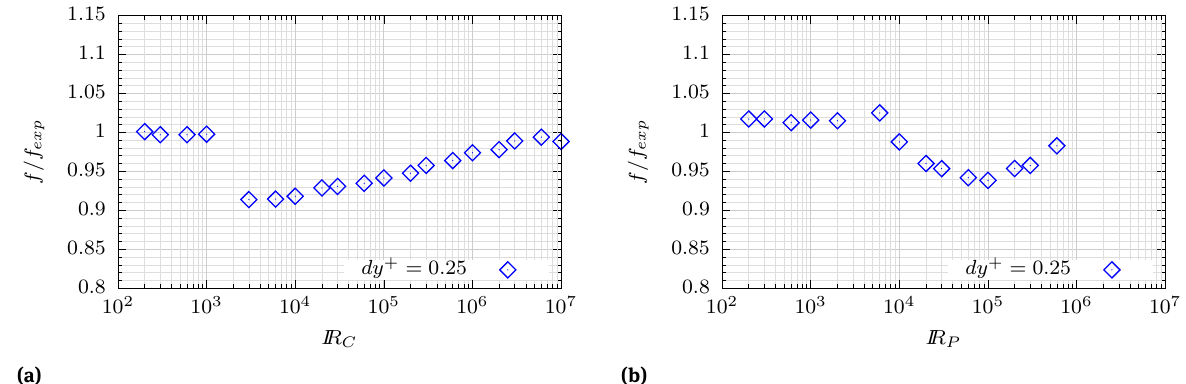
Figure 5: Relative error of friction factor from LRN treatment for circular pipes (left) and parallel plates (right).